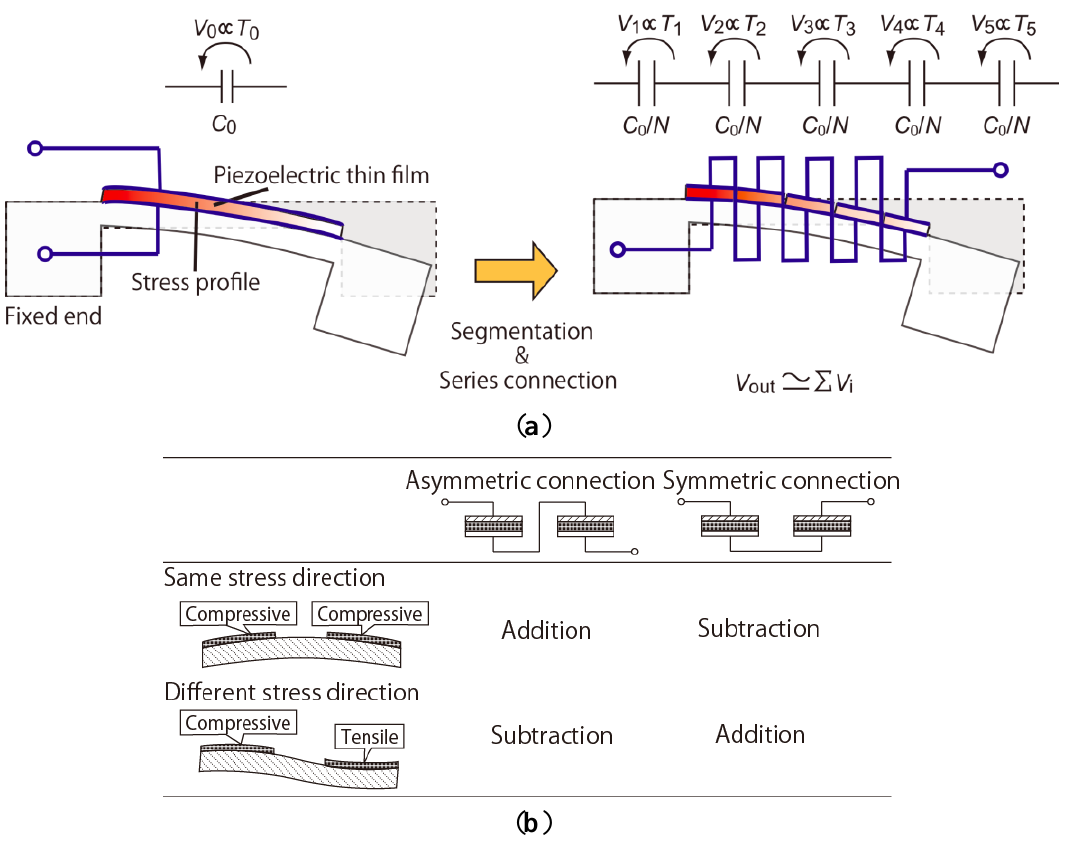
Figure 1. Diagram of output-voltage operation using series-connected piezoelectric